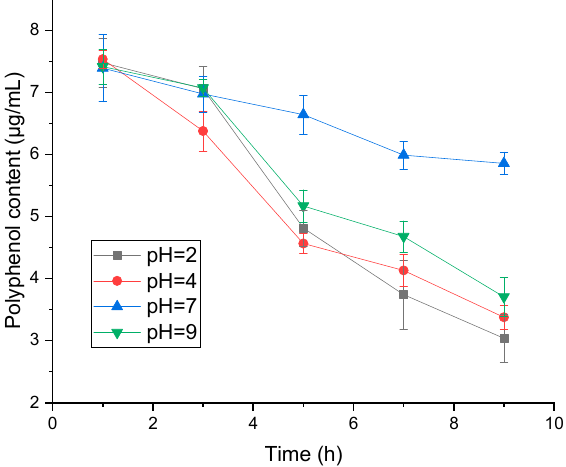
Figure 4. The stability of polyphenol from distiller’s grain in different environments with pH of 2, 4, 7, and 9 at room temperature in dark.